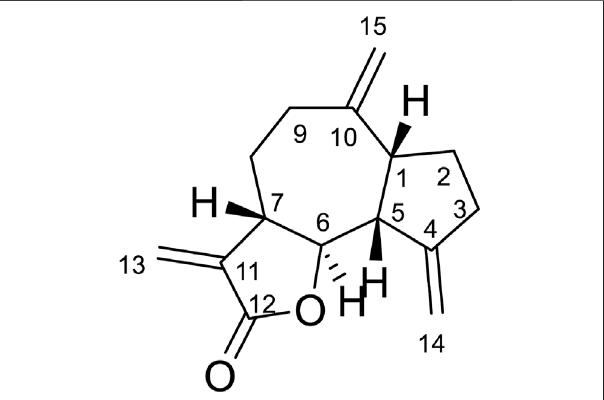
( Table 6 ) contained fi fteen carbon signals, which were assigned to one lactone carbonyl carbon ( δ c 170.6), six ole fi nic carbons ( δ C 141.4, 140.0, 136.9, 127.2, 127.0, 119.6), one